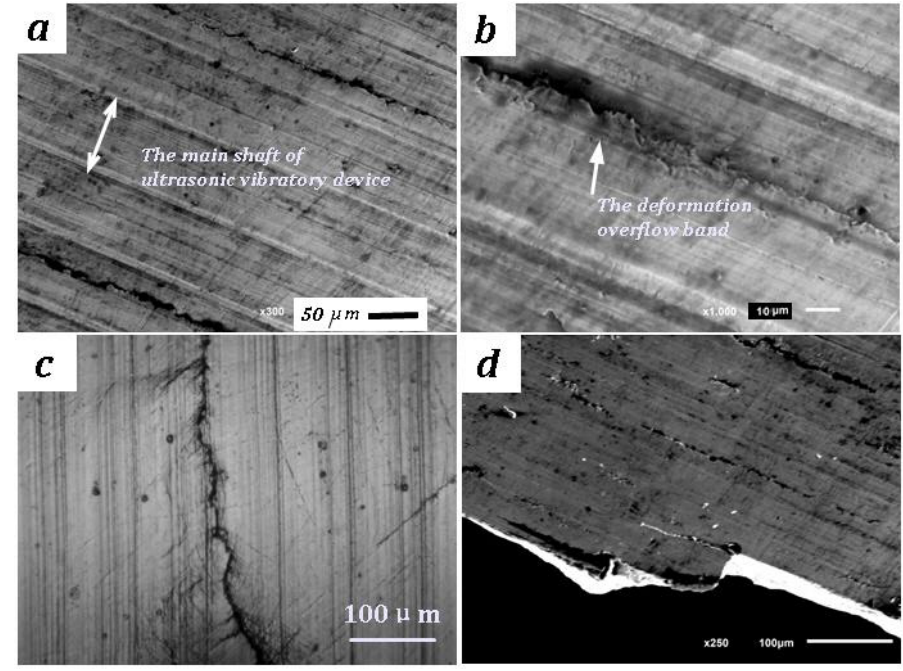
Figure 8. Observation of the surface crack: ( a ) Specimen surface after fatigue test; ( b ) Deformation overflow band; ( c ) Surface crack propagation; ( d ) Step of surface crack.